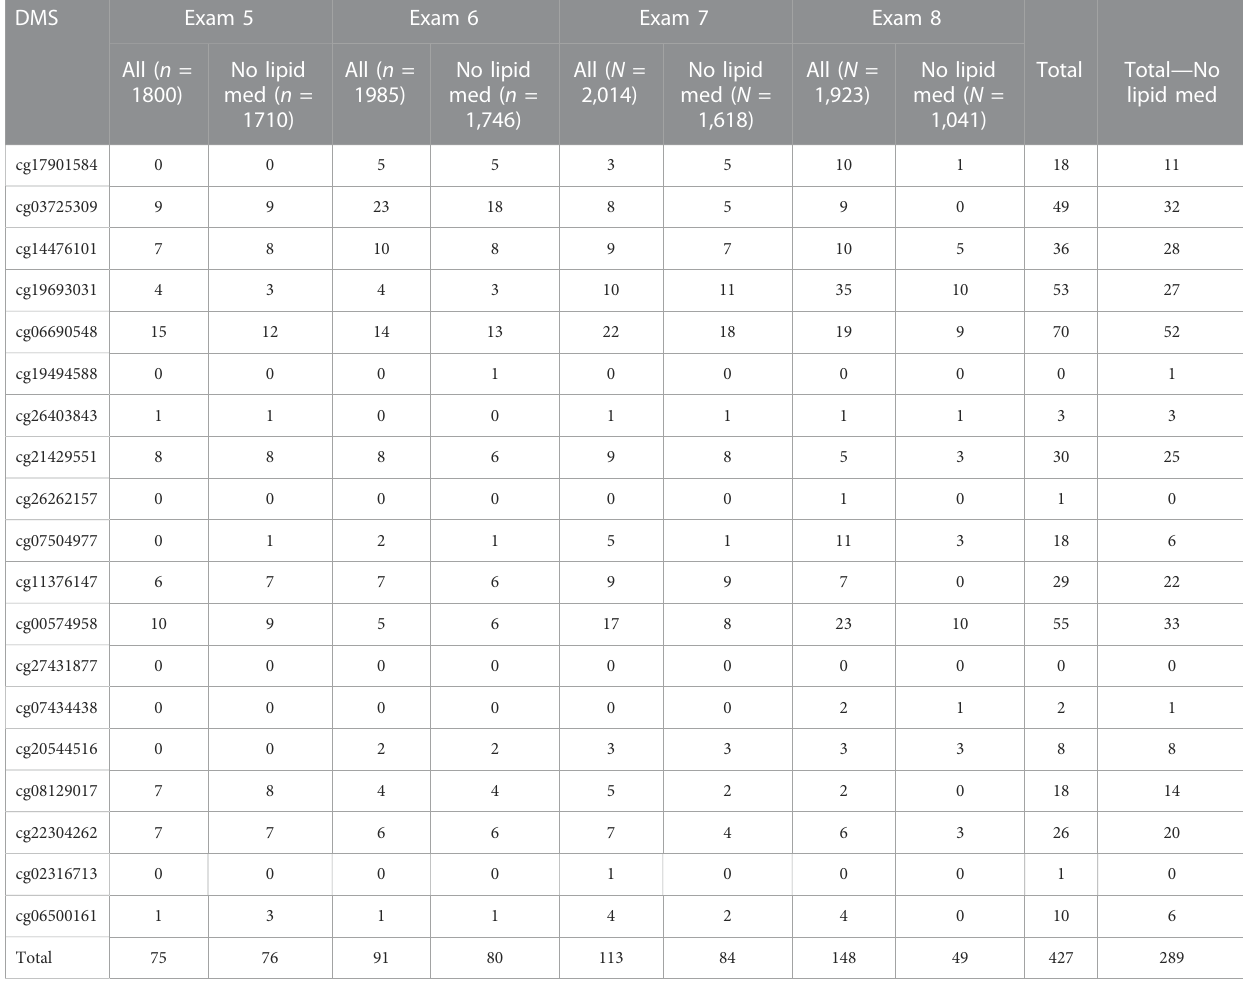
TABLE2Numbers ofdietaryandlifestylemeasuresthatwereassociatedwitheachof19 TG-associated epigeneticvariantsinfourexamsoftheFraminghamHeart